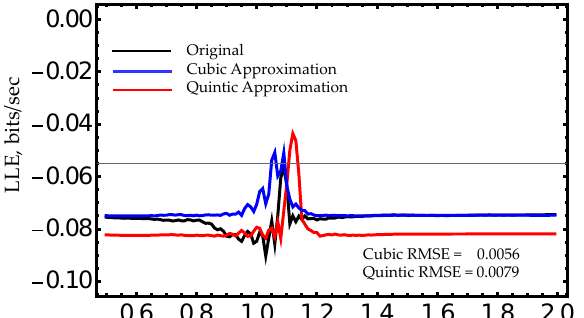
Figure 17. Frequency-amplitude response curves computed from the numerical integration solutions of Equations (53) and (54). Cubic approximation: ( a ) x 1 vs ω f , ( b ) x 2 vs ω f . Quintic approximation: ( c ) x 1 vs ω f , ( d ) x 2 vs ω f . The values used to obtain these plots were m 1 = m 2 = 1, k = 1, ε = 0.5 with c = 0.3 and f 1 = 0.25, with fitting parameter values for the quintic approximation of η 1 = 1, η 2 = 0.3, V 1 = 1, V 2 = − 0.15, η 11 = − 0.01, η 22 = 1, V 11 = 0, V 22 = 1, and weighted mean square error values of U 1 = 2.16 × 10 − 5 , U 2 = 0. Here, the black, solid lines describe the numerical integration solutions of Equation (30), while the blue, dashed lines are the numerical solutions obtained from the equivalent cubic and quintic expressions, (29), (53) and (54), respectively.